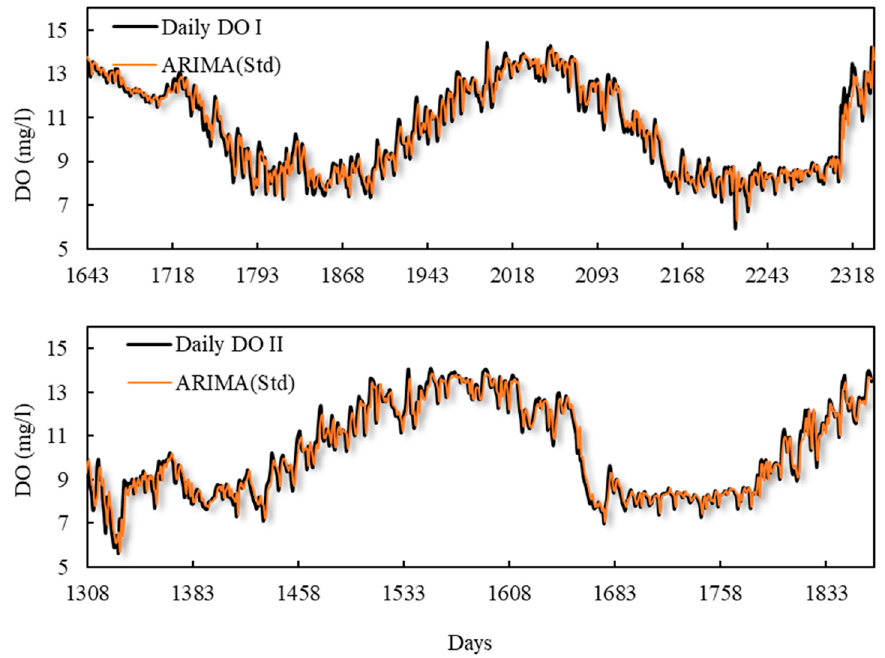
Min. and Max., Minimum and Maximum of data,1st Q. and 3rd Q., first and third Quarters, σ (n), Standard Deviation, γ 1 , Skewness, γ 2 , Kurtosis. Figure 9. The Taylor diagram of the modeled DO time series at both stations I and II.